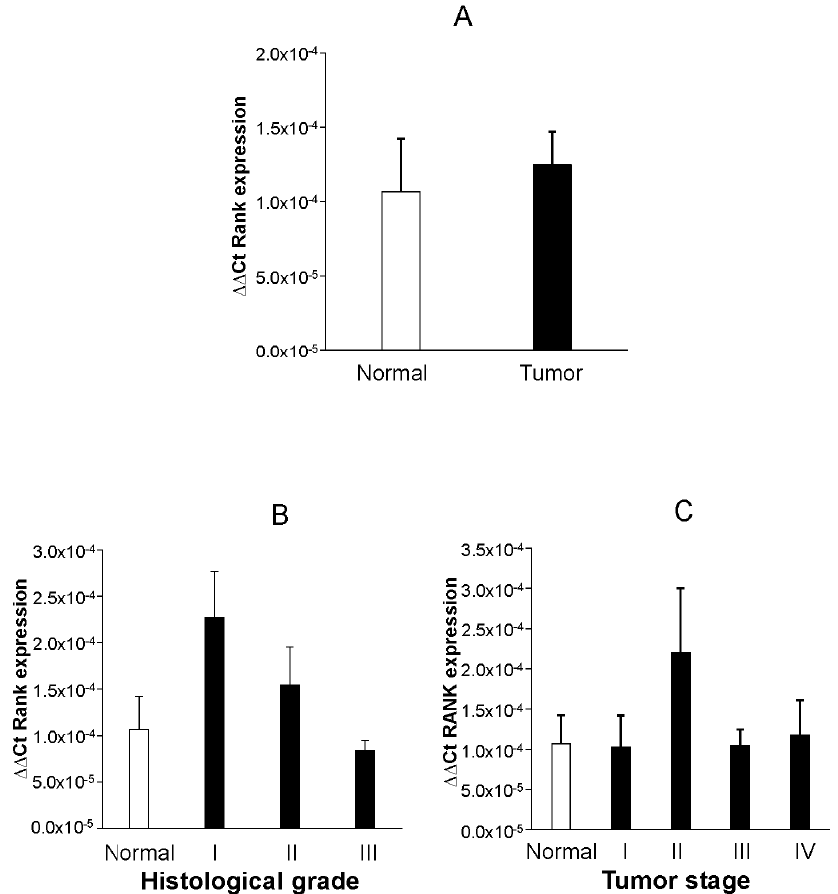
Figure 3. Graphs show mean ± SEM RANK mRNA expression as detected by RT-QF-PCR in endometrium from normal and endometrial tumor cases. A Mann–Whitney U test was employed for comparisons of RANK mRNA values between normal and overall endometrial tumor cases. ( A ) A Kruskal–Wallis followed by Mann–Whitney analysis were performed to detect differences between normal and tumor cases grouped according to their histological grade ( B ) or tumor stage ( C ). No statistically significant differences were detected.